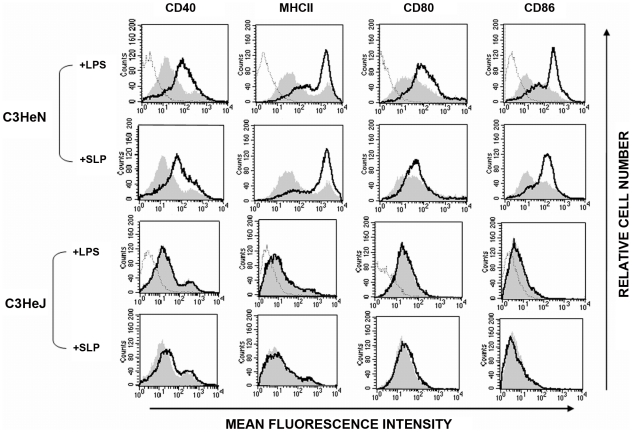
SLPs induce DC maturation via TLR4.DCs isolated from C3H/HeN or C3H/HeJ mice were incubated with either LPS (100 ng/mL) or SLPs (20 µg/mL) for 24 h. Cells were washed and stained with antibodies specific for CD40, CD80, CD86, and MHCII, or with isotype matched controls. Results of immunofluorescence analysis are shown for control DCs (filled histogram) and DCs treated with either LPS or SLPs (thin black line). Histograms for isotype controls are shown as dotted lines in the first row only.